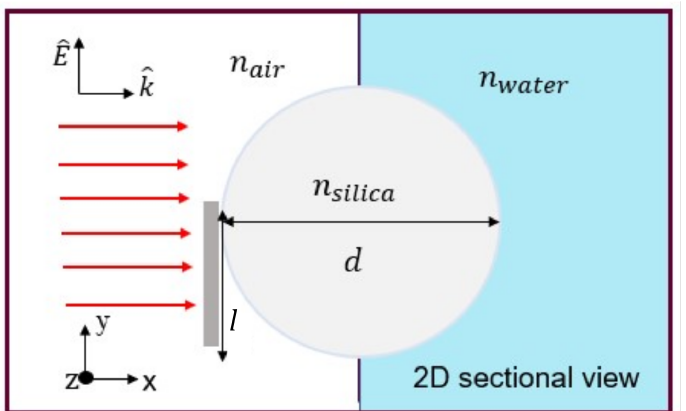
Figure 1. Schematic illustration of the numerical model for PNJ & PH formation in a step-index medium with 2D cross-section of auxiliary structure made of silica. Plane-wave illuminates a mask in air, in the direction indicated by vector k . Mask is partially blocking the cylinder. The generated beam is created in